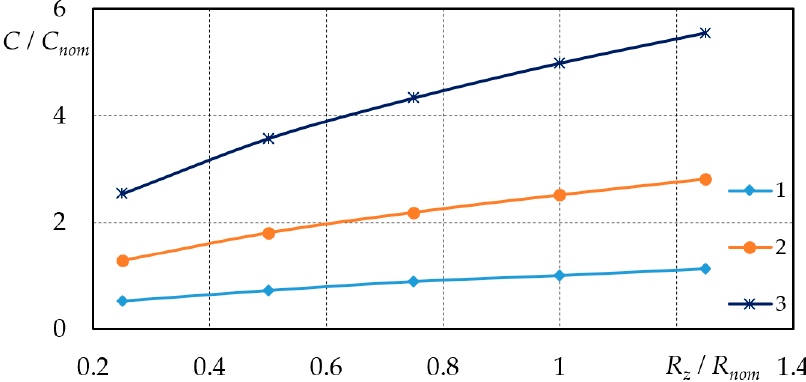
Figure 10. Dependence of stiffness of B tire tread part with a pattern on the tread height: 1—new tire; 2—worn by 50%; and 3—worn out. 2—worn by 50%; and 3—worn out.